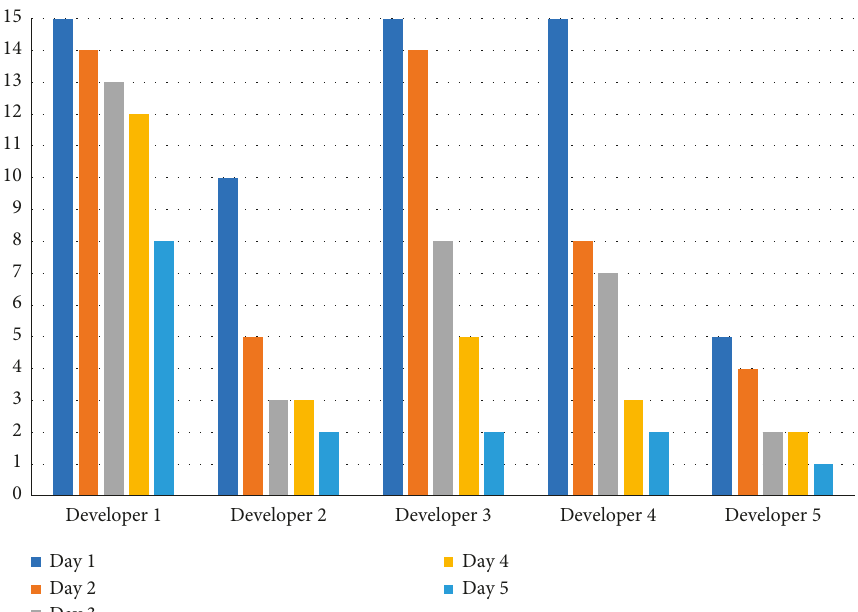
Figure 6: Number of repetitive mistakes of five